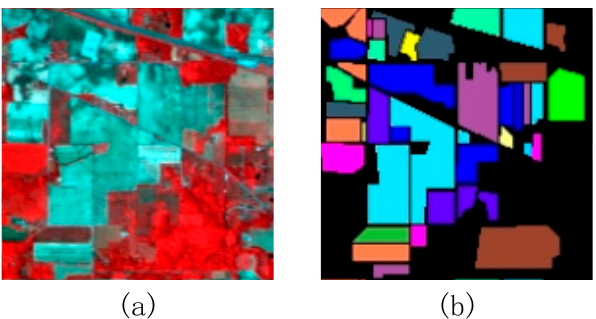
Figure 6 The Indian Pine dataset: ( a ) a false color composite image and ( b ) the ground truth.